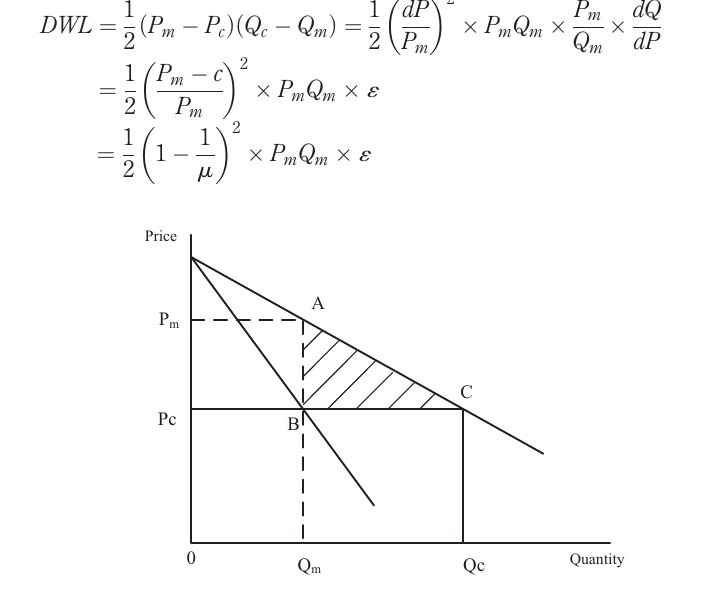
Figure 1. Harberger triangles represent